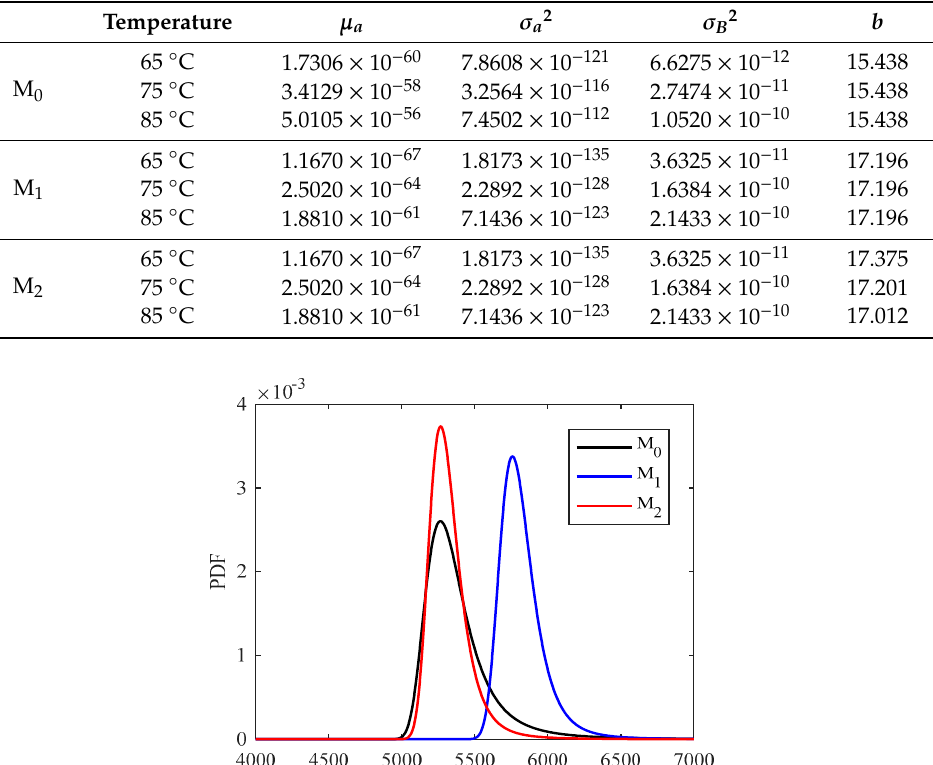
Figure 1. Comparison of probability density function (PDF) of lifetime at 20 °C for accelerometers. Table 6. Distribution parameters of lifetime under each accelerated stress based on three methods for accelerometers.